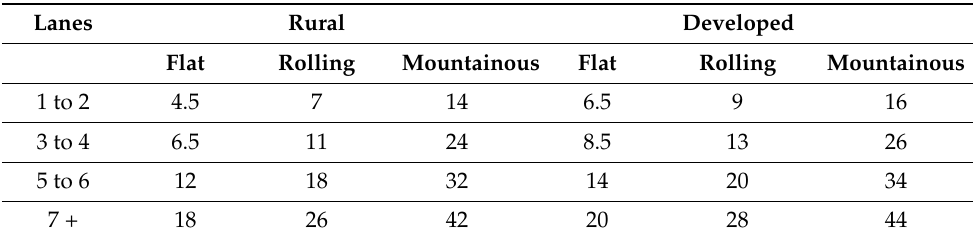
Table 4. Value of various roads in Kentucky, incorporating lane amount and terrain type. Cost values are in U.S. dollars and per 1.6 km ( × $1,000,000). Lanes Rural Developed Flat Rolling Mountainous Flat Rolling